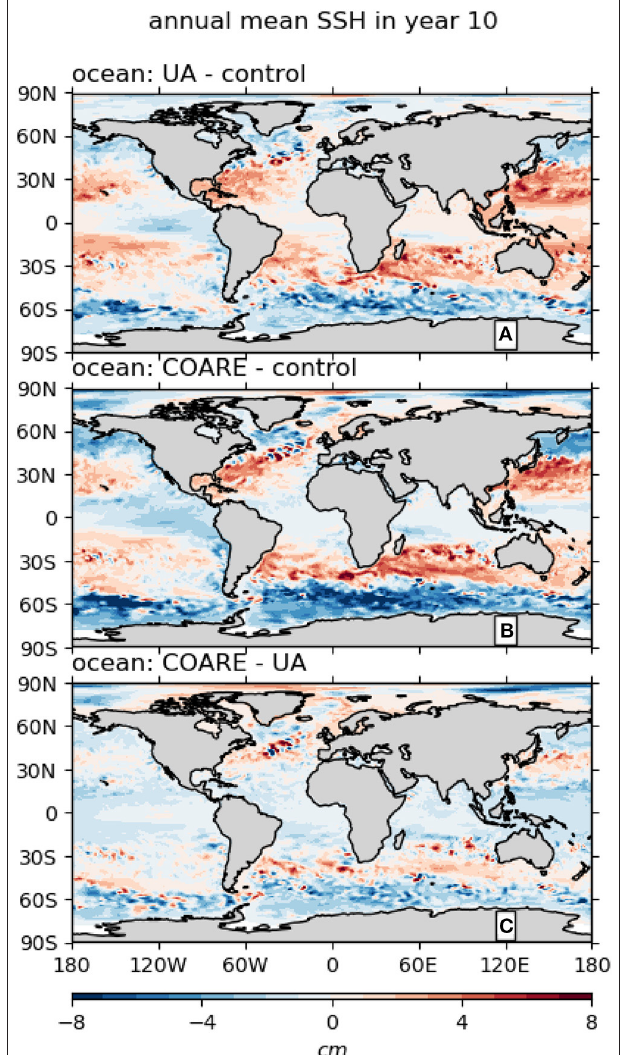
FIGURE 8 | Differences in model year 10 sea surface height between simulations with different ocean surface bulk flux parameterizations. The changes in sea surface height due to evaporation differences have been removed as in Equation